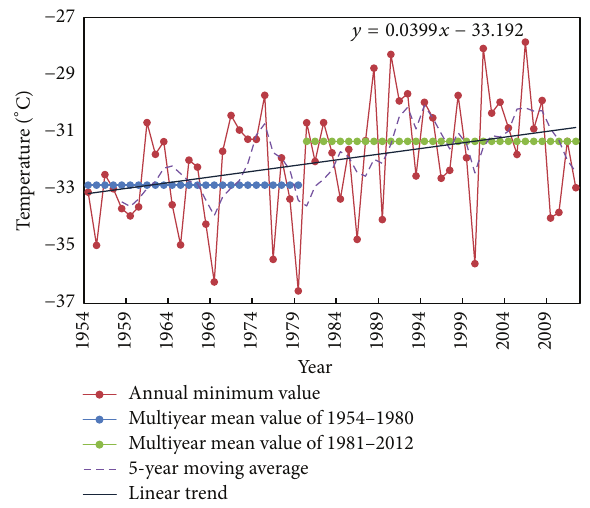
Figure 11: Long-term changes in area-averaged annual minimum temperature ( ∘ C) in the Amur River